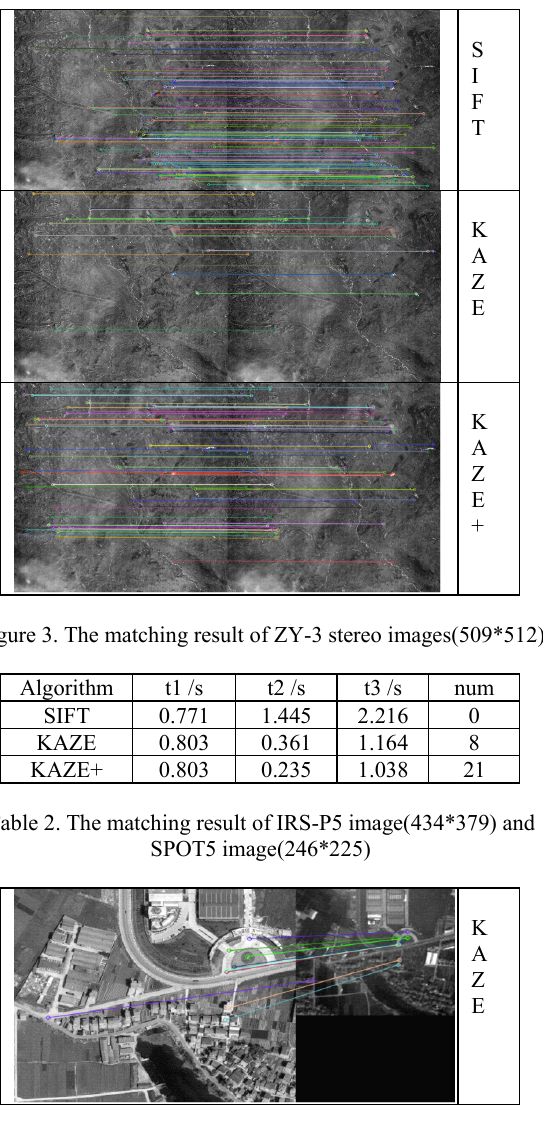
Table 1. The matching result of ZY-3 stereo images(509*512)